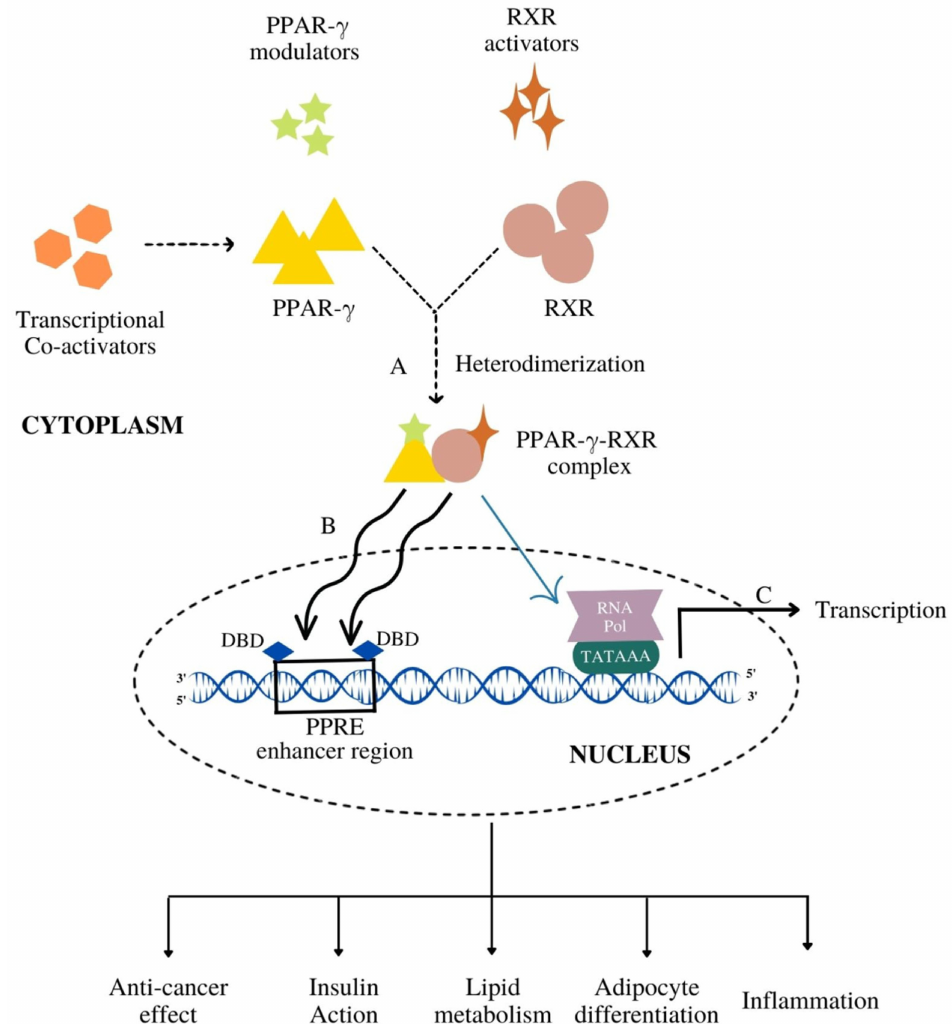
Figure 3. The mechanism of PPAR- γ activation followed by the gene transcription. ( A ) PPAR- γ upon binding with its modulators (endogenous, natural, synthetic) heterodimerize with RXR to form PPAR- γ -RXR heterodimerized complex. ( B ) This complex gets translocated inside the nucleus and binds to the DNA-binding domain (DBD) of PPAR response elements (PPRE) enhancer region. ( C ) Such a binding leads to the transcriptional activation of target genes resulting in various metabolic cascades such as insulin action, lipid metabolism and anti-cancer